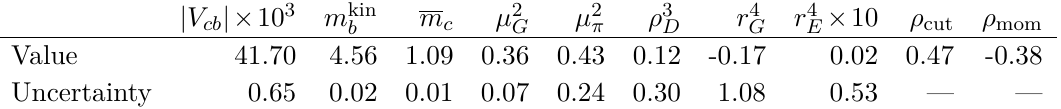
(1 GeV) , ¯ m (2 GeV) , the c b and ρ . All parameters are expressed in cut mom